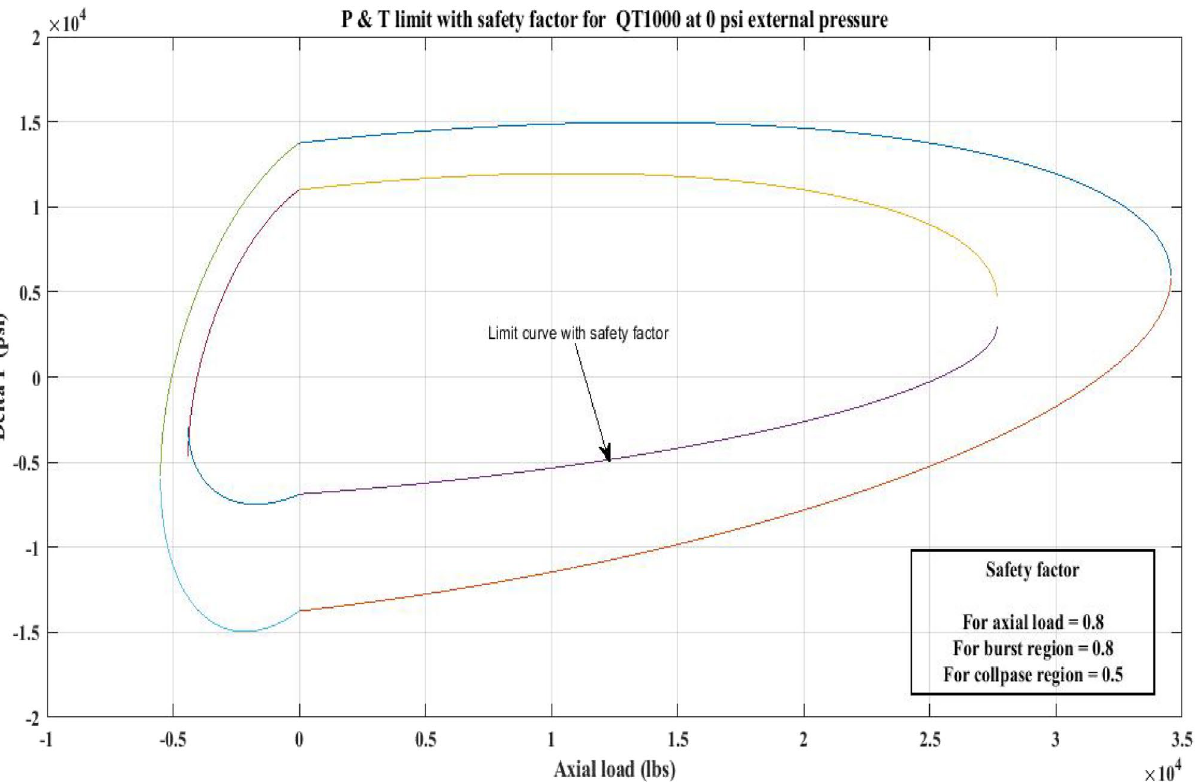
Figure 22. P and T limit with safety factor for QT 1000 at 0 P o